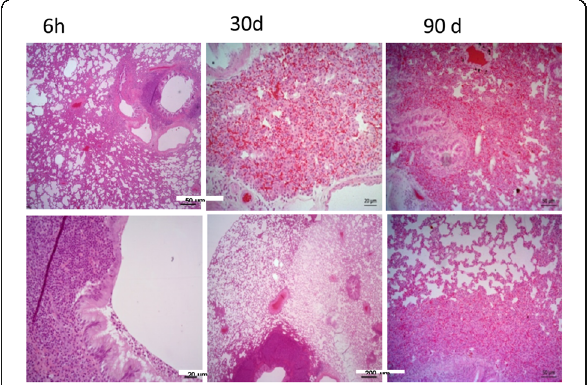
Fig. 1 (abstract P17). Pathological aspects found in the lung of sepsis survivors in the periods of 6 hours, 30 days and 60 days